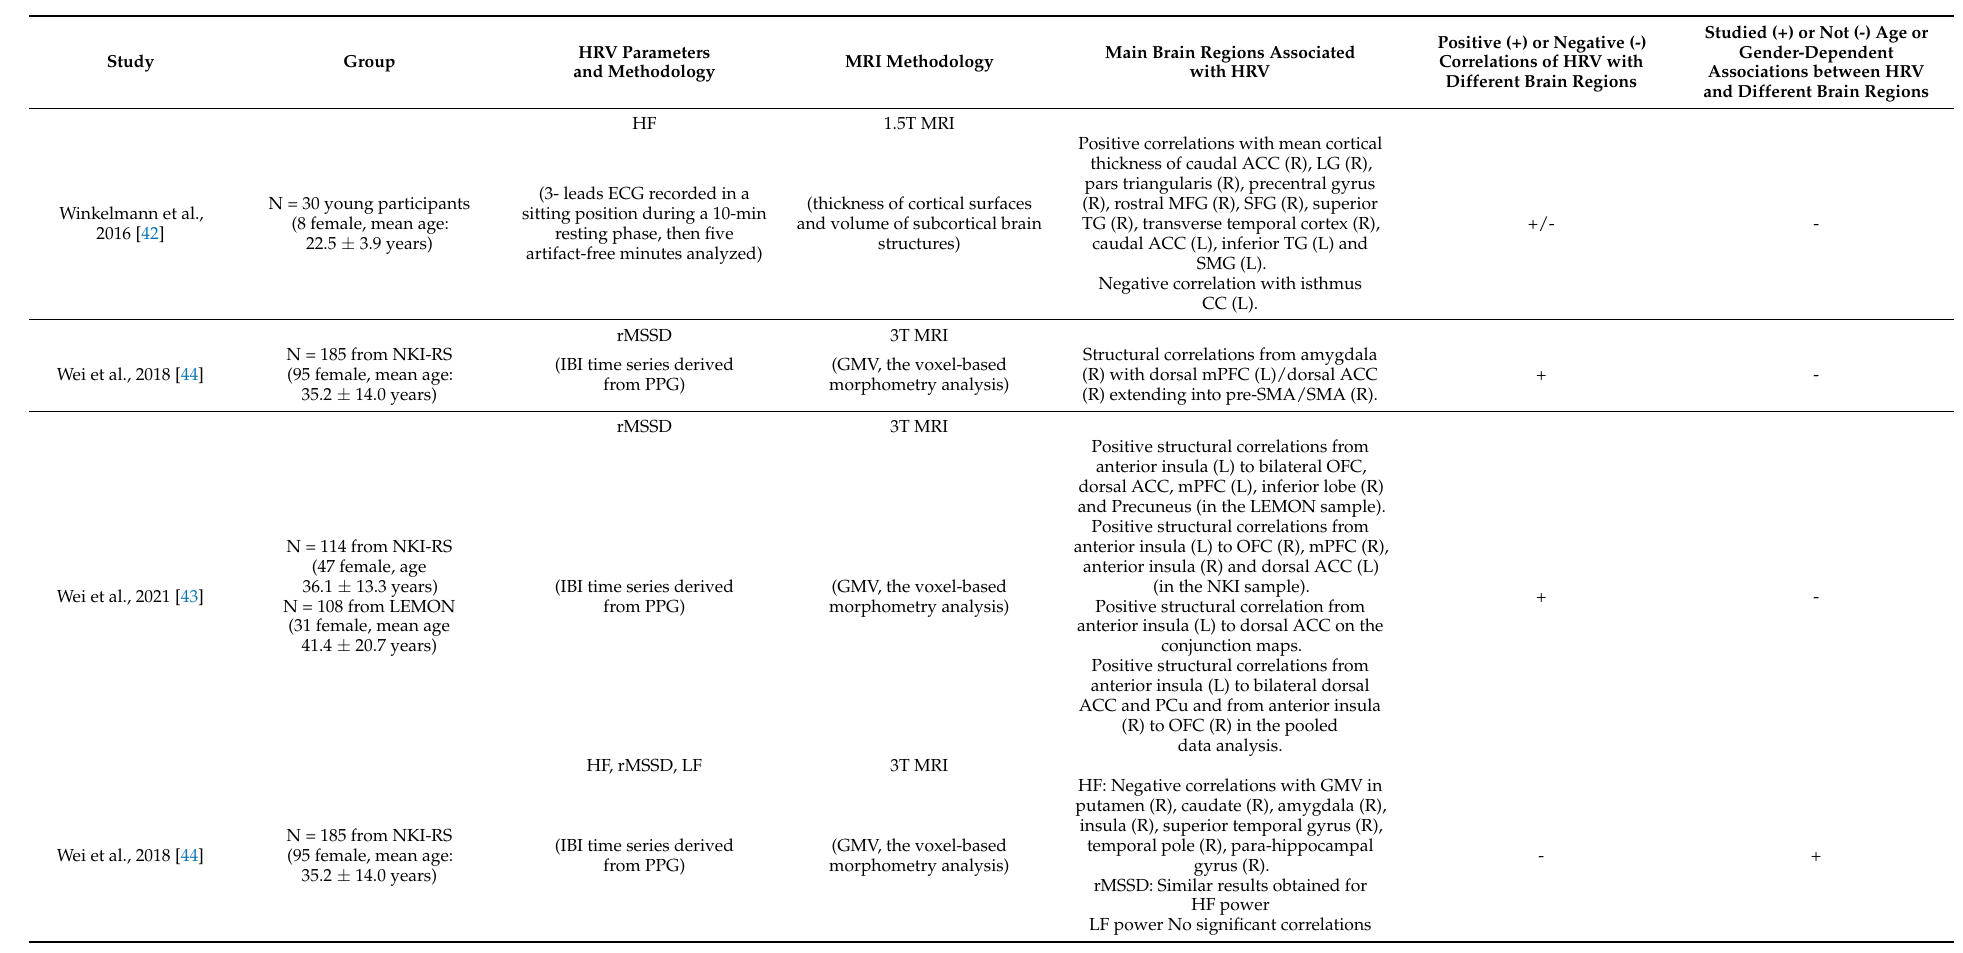
Table 2. Findings of published cross-sectional studies describing associations of heart rate variability and brain morphology or structural covariates during the resting